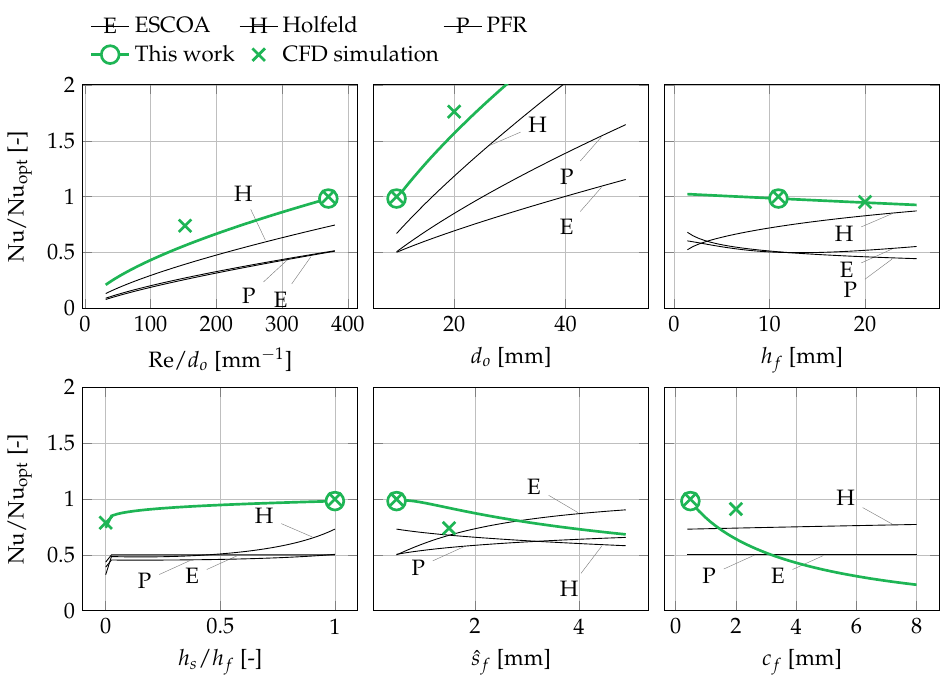
Figure 8. Trends in correlations around the case study optimum found using correlations developed in this work (marked by a circle). CFD simulations were independently sampled (not part of the dataset used for model development). Each parameter was varied independently, with remaining parameters held constant at the